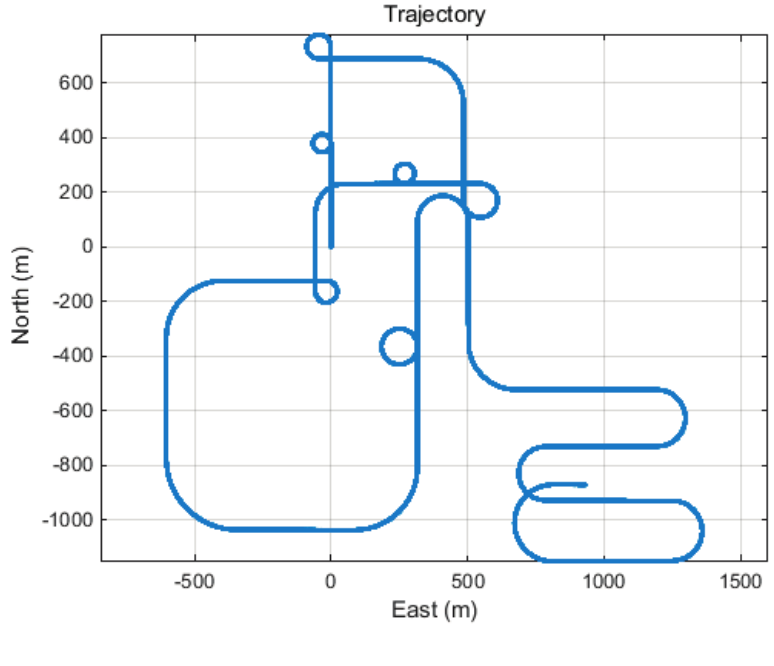
Figure 7. Generated user